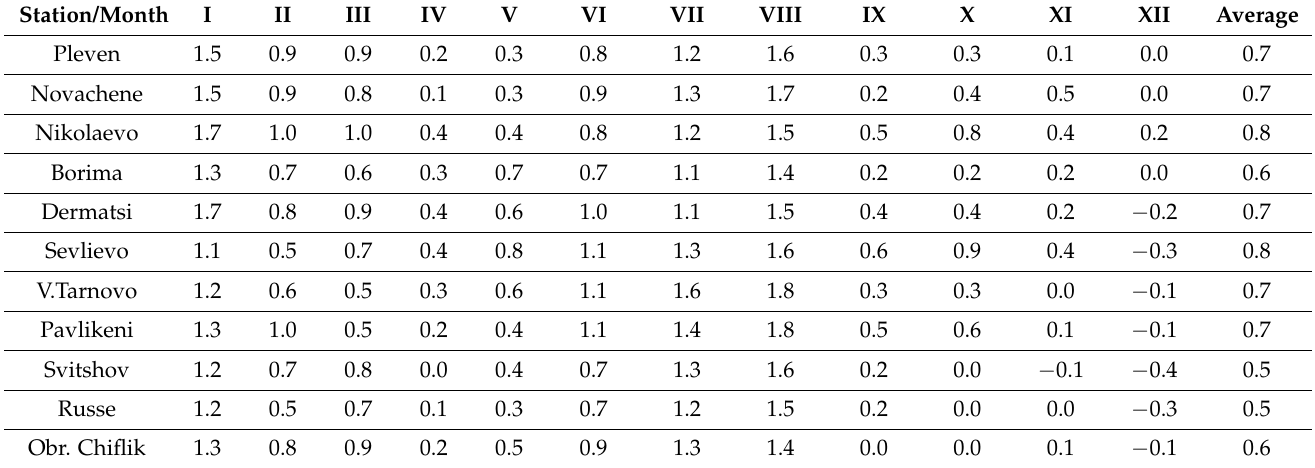
Table 3. Average monthly temperatures deviations in central north Bulgaria in the period 1986–2015.